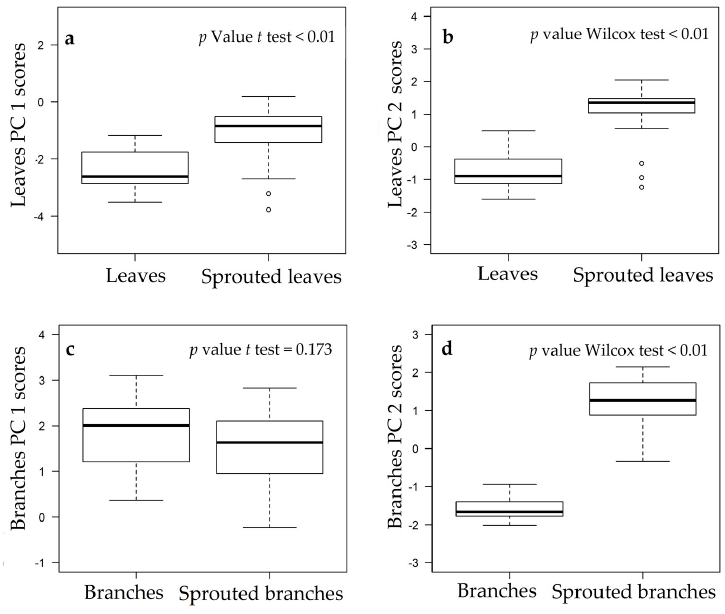
Figure 3. Box plot and p values of paired mean tests comparing PCA scores of leaf and branch chemical attributes data for “reference” and “regrowth” material collected by sequential management of rosewood above ground mass in the three study areas. ( a ) PC 1 Scores for leaf chemical attributes; ( b ) PC 2 Scores for leaf chemical attributes; ( c ) PC 1 Scores for branch chemical attributes; ( d ) PC 2 Scores for branch chemical attributes.